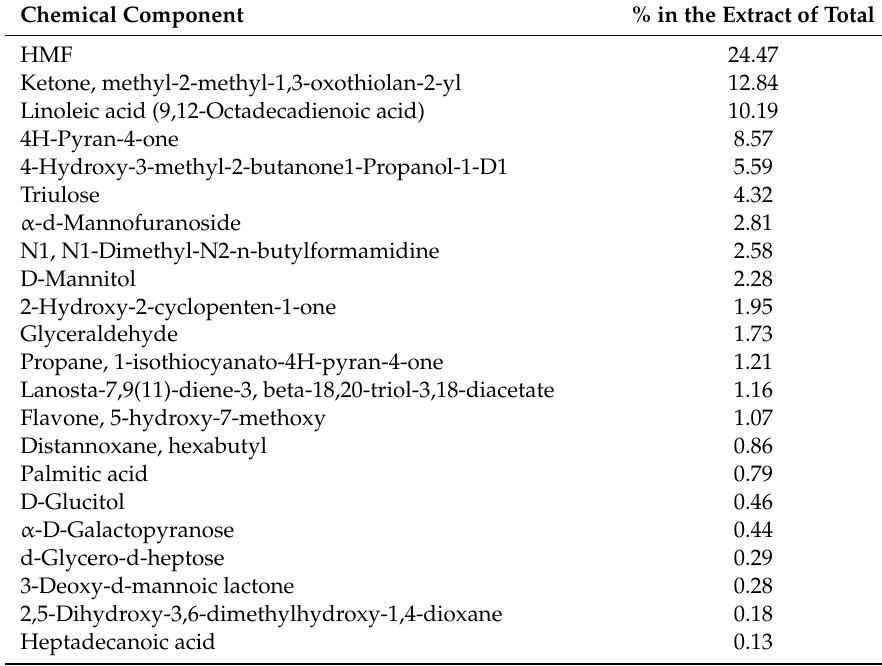
Table 4. List and percentages of chemical components of the citrus bee honey, refined propolis, palm pollen grains, and royal jelly mixture that was analyzed using gas chromatography-mass spectrometry (GC-MS) and identified from the mass spectrum of each molecule using the Wiley9 and NIST14 mass spectral databases. Then, individually listed compounds were re-confirmed through the online databases AMDIS, PubChem, ChemSpider, and Chinese Chemical